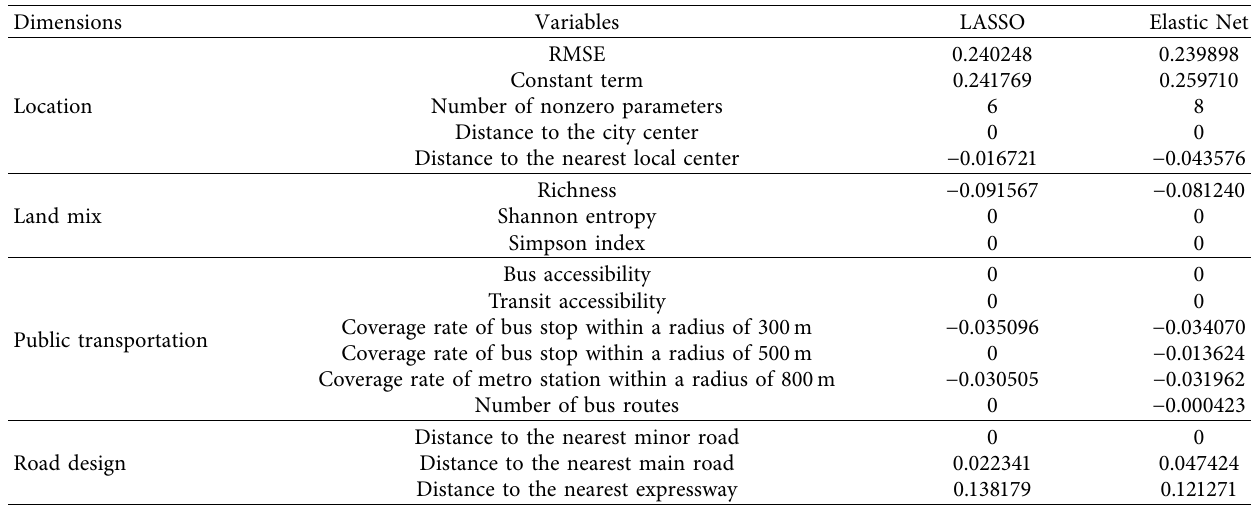
Table 3: Regression results of LASSO and Elastic Net